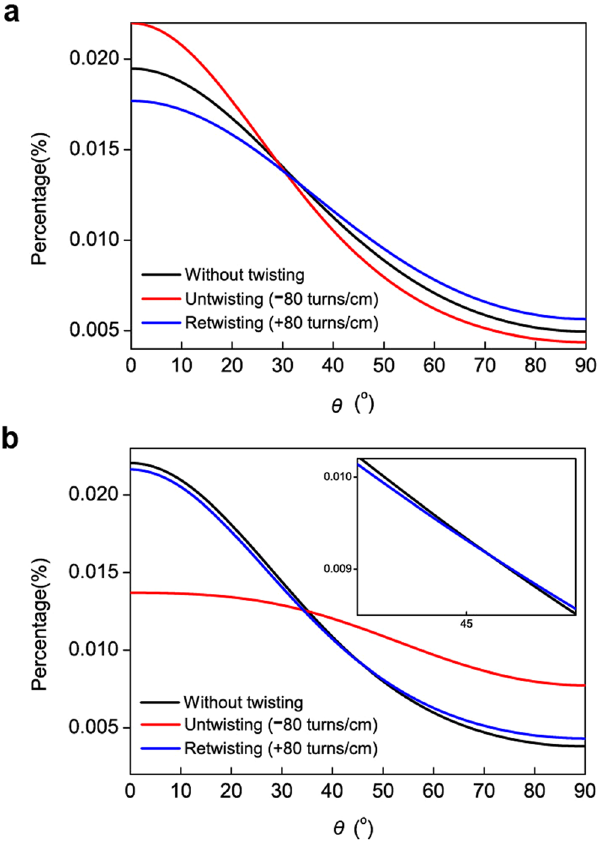
Figure 6. Orientation angle of individual CNTs in two-tethered CNT yarn (Fig. 3(b)). ( a ) CNT orientations obtained around the fixed end of the CNT yarn without twisting or untwisting, with untwisting ( − 80 turns cm − 1 ) and with retwisting ( + 80 turns cm − 1 ), respectively. ( b ) CNT orientations obtained around the middle between the lower fixed end and the yarn